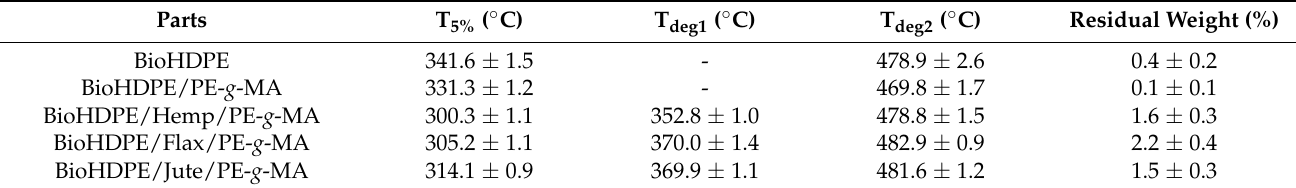
Table 4. Main thermal degradation parameters of the samples of Bio-HDPE with different natural fibers in terms of: temperature at mass loss of 5% (T 5% ), degradation temperature (T deg ), and residual mass at 700 ◦ C. Parts T 5% ( ◦ C) T deg1 ( ◦